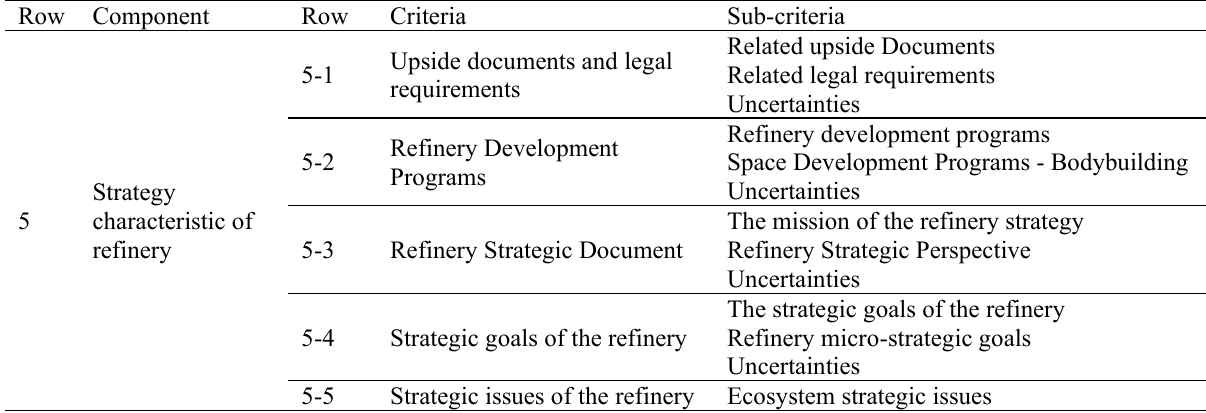
Table 5. Strategic components and criteria for strategic characteristic of refinery Row Component Row